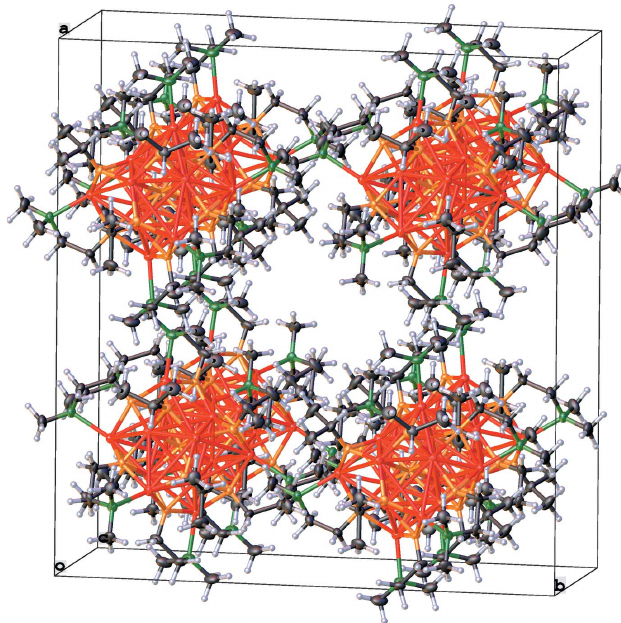
Figure 5 View of the crystal packing of 1 parallel to the ac plane and the bc